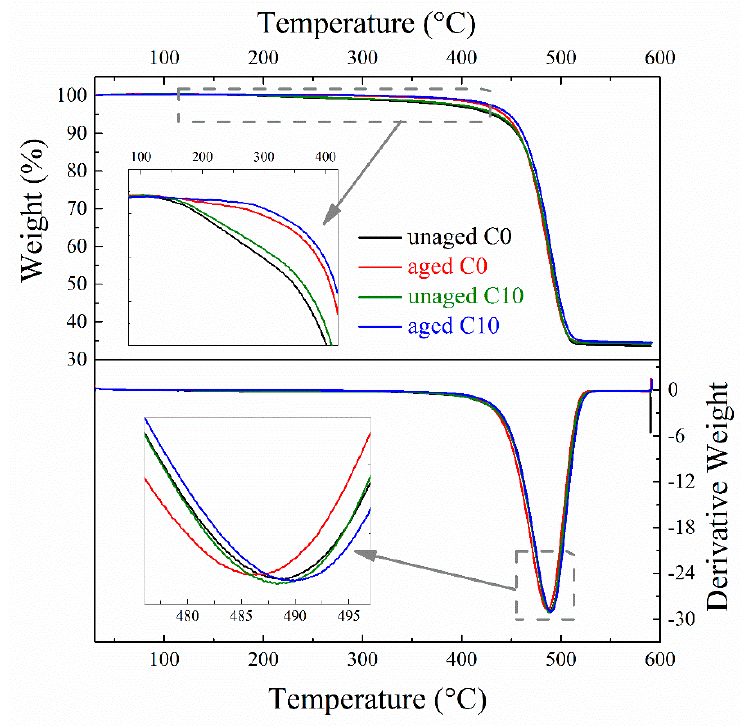
Figure 8. TGA curves of unaged and aged EPDM composites (aging condition: 150 °C × 168 h). Table 3. TGA parameters for unaged and aged EPDM composites (aging condition: 150 °C × 168 h).